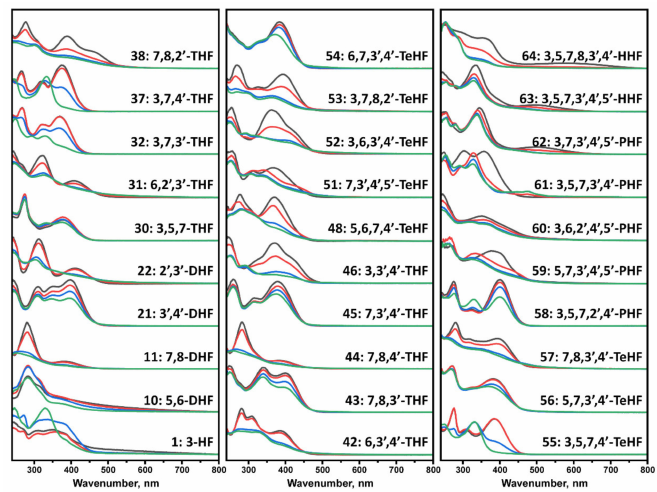
Figure 1. UV-visible absorbance spectra of flavones, recorded at 0 h (black), 5 h (red), 40 h (blue), and 100 h (green). Spectra were baseline corrected at 800 nm. Most of the flavone spectra experienced a significant change in the 250–450 nm region. In contrast, 21, 30, 43, 45, 54, 56, 60, and 62 experienced only a slight transition of maxima or decrease in the magnitude of the initial absorbance spectrum.